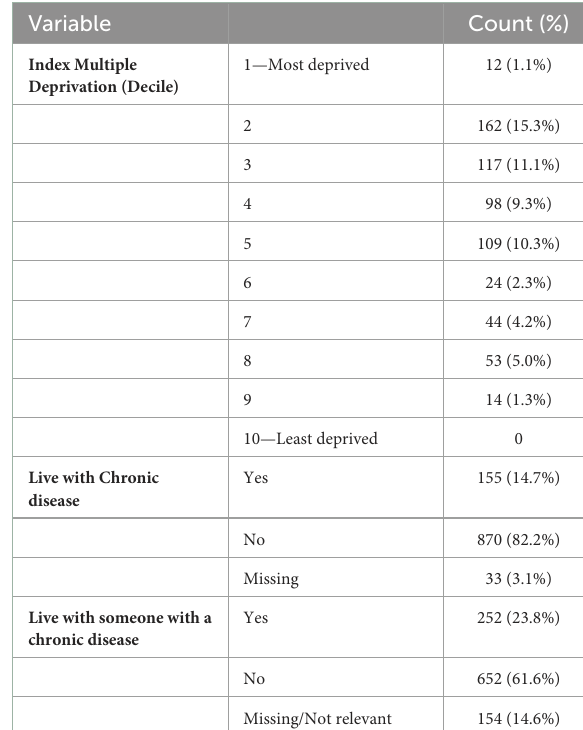
TABLE 1 Descriptive characteristics of the sample ( N =